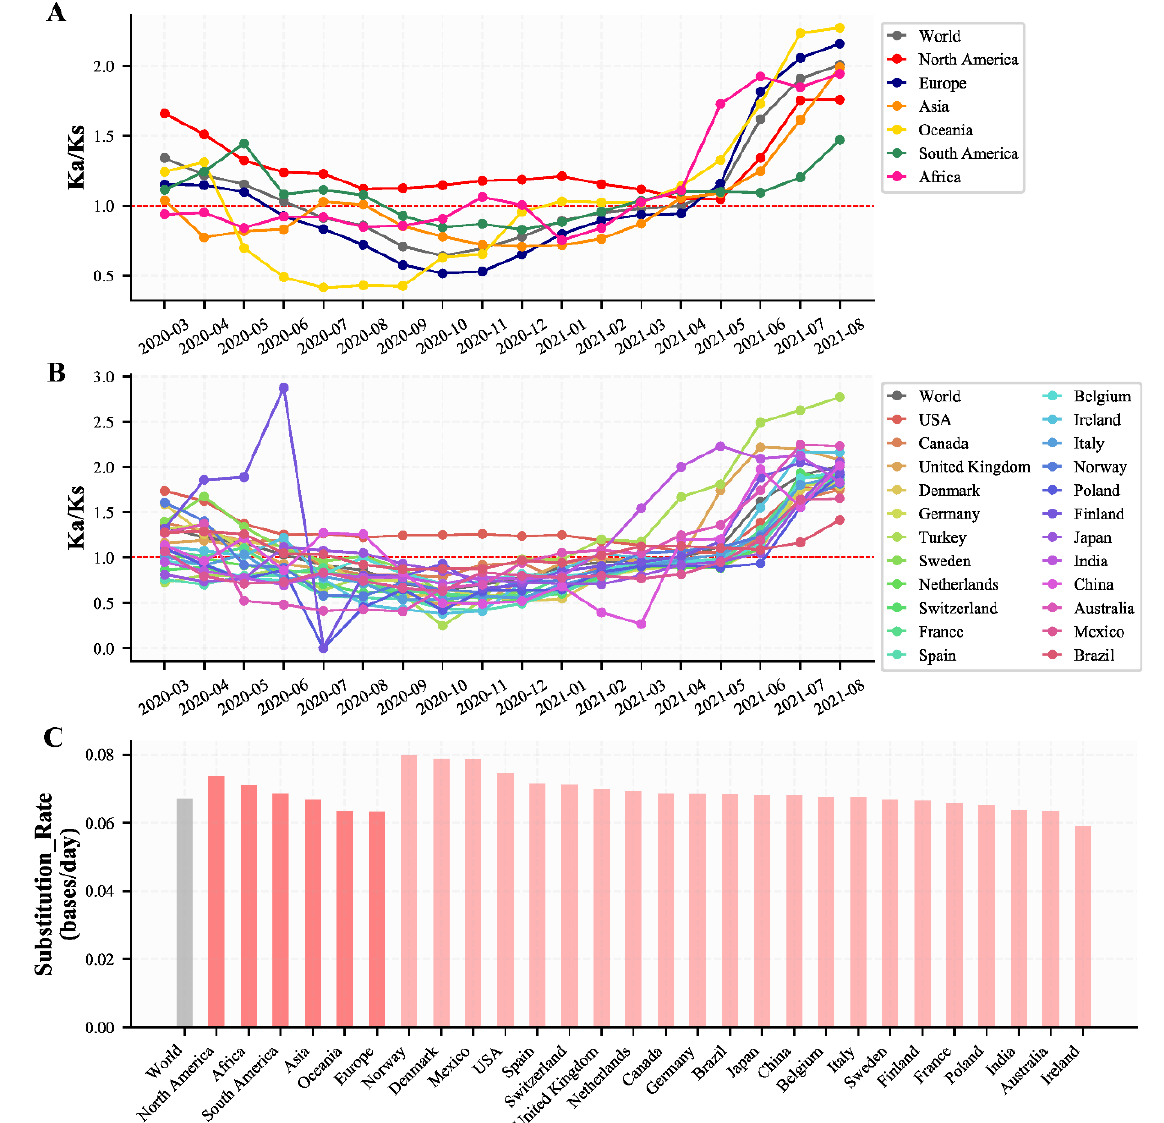
Figure 4. The Ka/Ks and substitution rate of H1 haplotype subtype. ( A ) The changes of the Ka/Ks of H1 haplotype subtype in different continents. ( B ) The changes of the Ka/Ks of H1 haplotype subtype in different countries or regions with more than 10,000 genome sequences and China. ( C ) The estimated substitution rate of the H1 haplotype subtype in different continents and countries or regions. The estimated substitution rate of the H1 haplotype subtype in Turkey was not plotted because it had a small Pearson correlation coefficient (r =